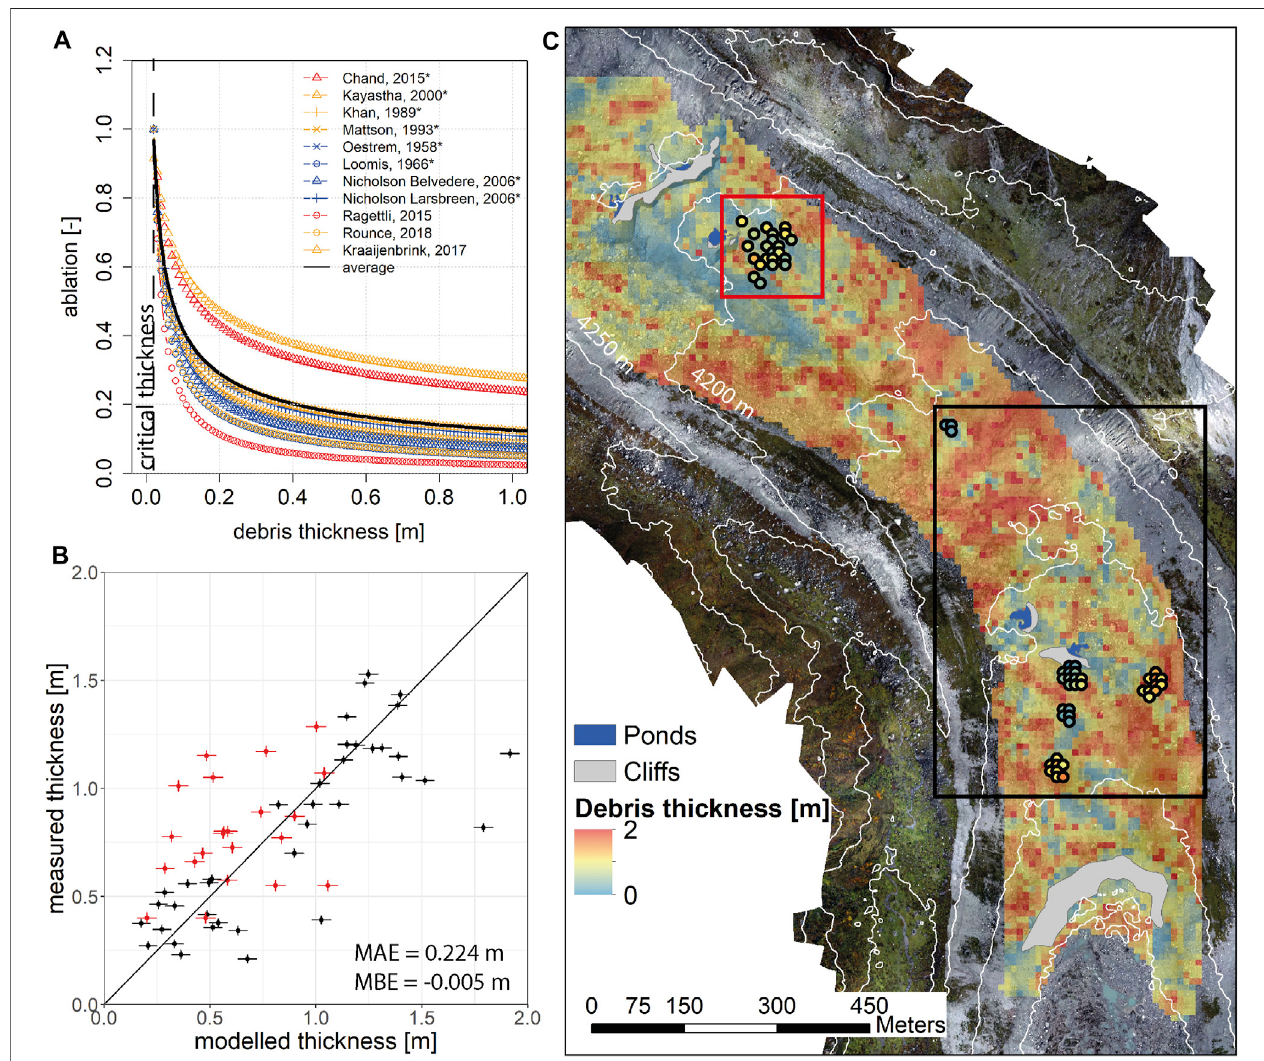
FIGURE 3 | (A) Standardized Østrem curves for all studies with fi eld data (*) and three modeling studies. Only data from fi eld studies was used to generate the average curve. The vertical dashed line shows the critical thickness, where melt is equal to a clean ice glacier in the same climate (2 cm). In red are studies from Lirung Glacier, yellow are from HMA, blue are studies from other regions. (B) Modeled compared to measured debris thickness at 10 m resolution, red are from pits and black from GPR measurements as noted by the squares in (C) . (C) Modeled debris thickness map. Points shown in the black frame are from GPR measurements, red frame denotes excavated